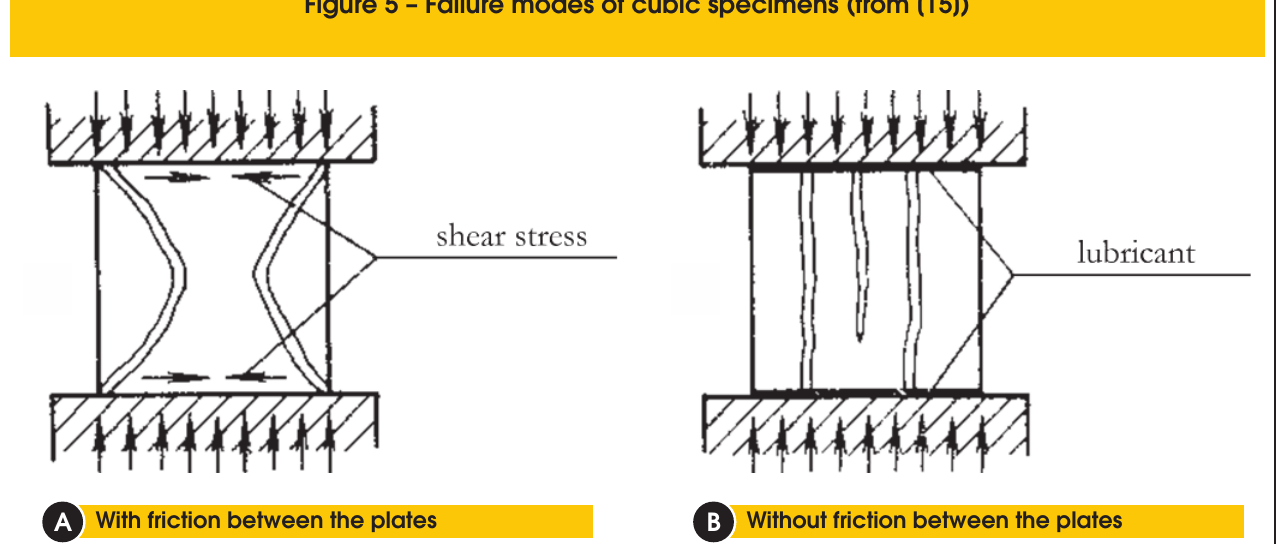
Figure 5 – Failure modes of cubic specimens (from